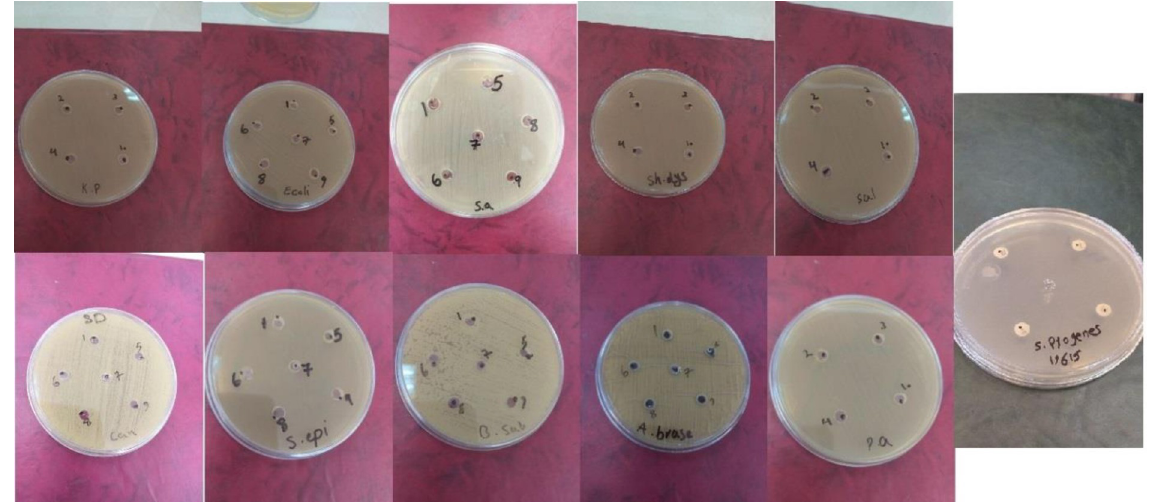
Fig 1. Agar well-diffusion of R . damascene EOs.